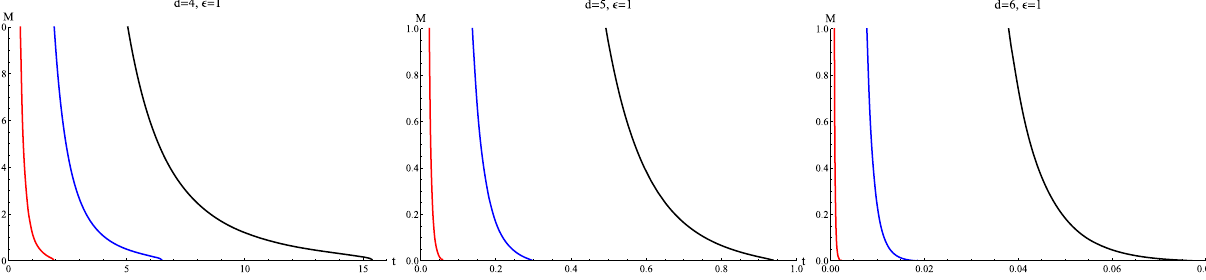
Fig. 3 The evolution of the black hole in d = 4 , 5 , 6 and (cid:2) = 1. The initial mass M 0 is taken to infinity. In each figure from left to right the curves correspond to (cid:3) = 0 . 1, (cid:3) = 0 . 15 and (cid:3) = 0 . 2,